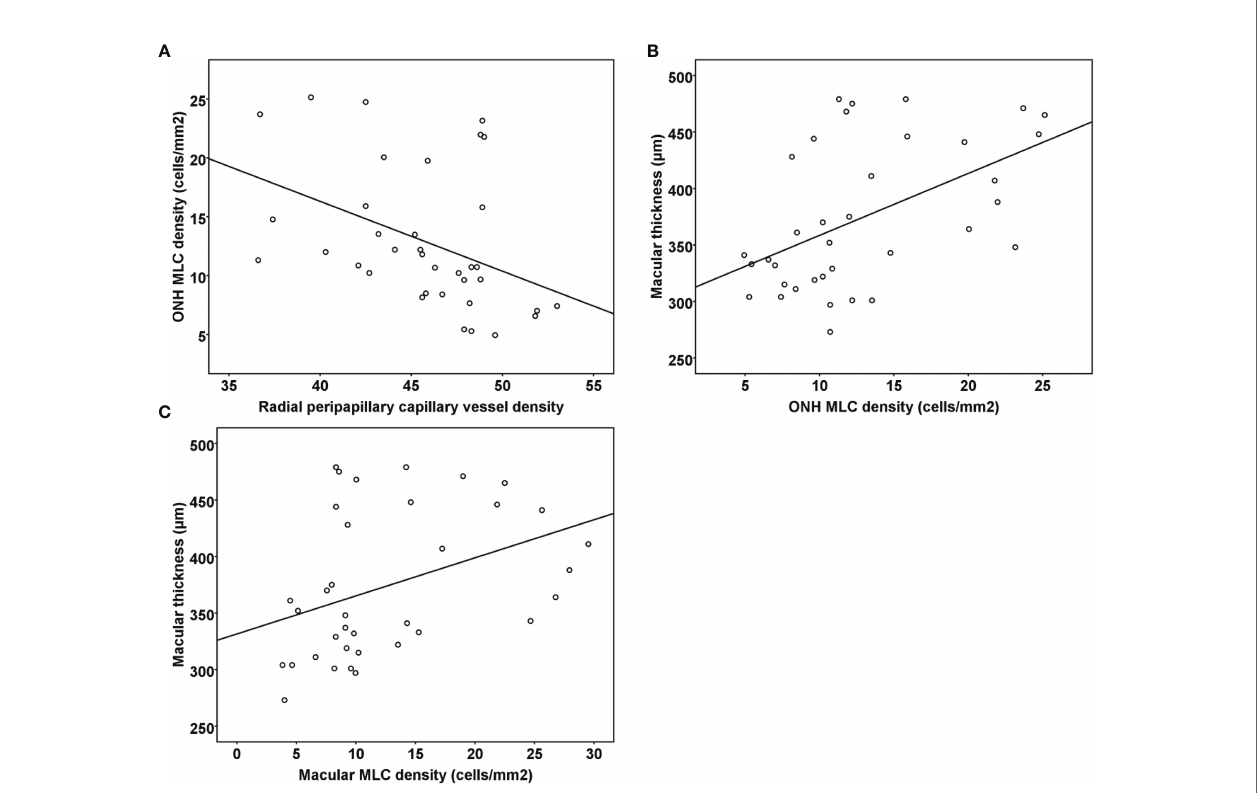
FIGURE 4 | (A) Scatter plots demonstrating the association between radial peripapillary vessel density and ONH MLC density in the RVO eyes. (B) Scatter plots demonstrating the association between ONH MLC density and macular thickness in the RVO eyes. (C) Scatter plots demonstrating the association between macular MLC density and macular thickness in the RVO eyes. ONH, optic nerve head; MLC, macrophage-like cell; RVO, retinal vein